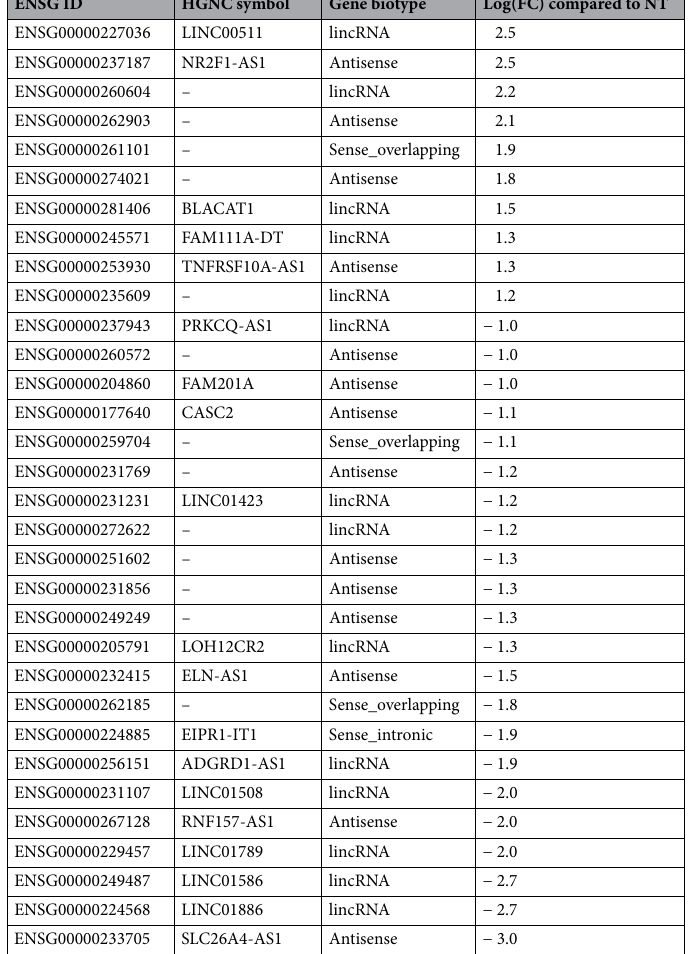
Table 6. LncRNAs specific for